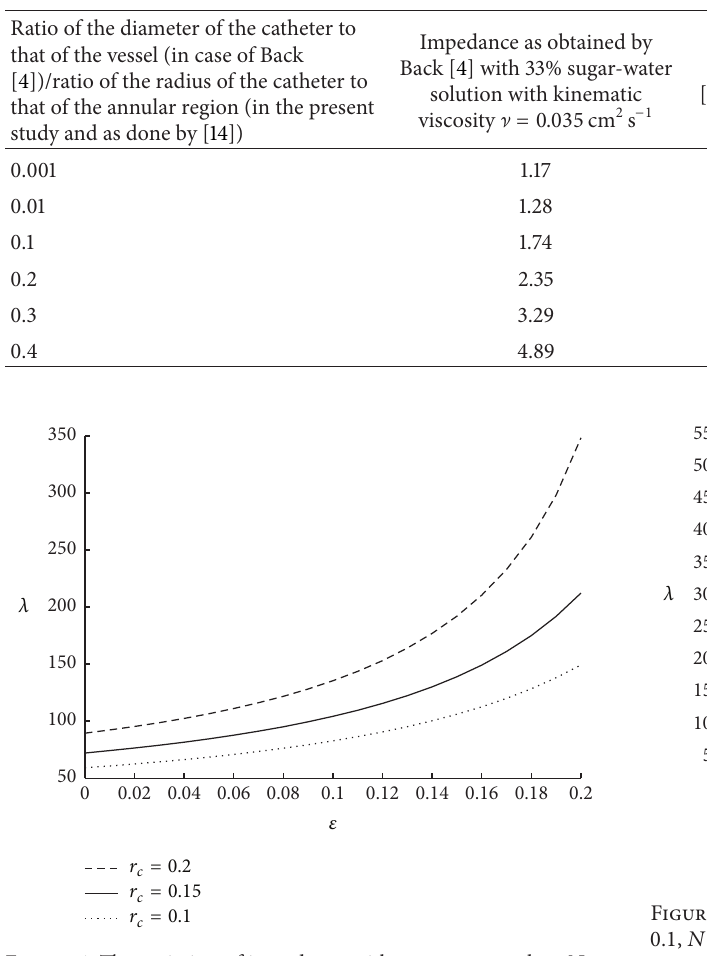
Figure 4: The variation of impedance with respect to 𝑟 𝑐 when 𝑁 = 0.75 , 𝑚 = 50 , Γ = 0.5 , 𝑢 = 0.01 , and 𝜙 = −0.05 .